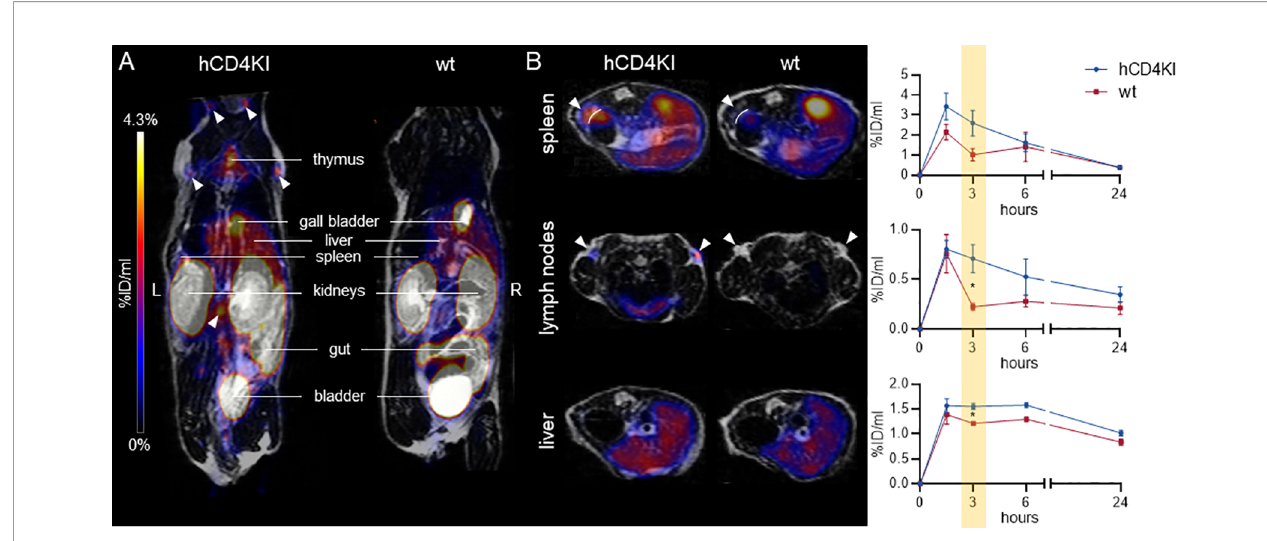
FIGURE 6 | 64 Cu-CD4-Nb1 speci fi cally accumulates in CD4 + T cell-rich organs. (A) Representative maximum intensity projection PET/MR images of human CD4 knock-in (hCD4KI) and wild-type (wt) C57BL/6 mice 3 h post intravenous (i.v.) injection of 64 Cu-CD4-Nb1. White arrows indicate localization of lymph nodes. (B) Exemplary transversal PET/MR images of spleen, lymph nodes, and liver (3 h post injection) and dynamic organ uptake quanti fi cation of 64 Cu-CD4-Nb1 over 24 h [n = 3 per group, arithmetic mean of the % injected dose per ml (%ID/ml) ± SEM, unpaired t-test of the 3-h time point, * p < 0.05]. White arrows indicate the target